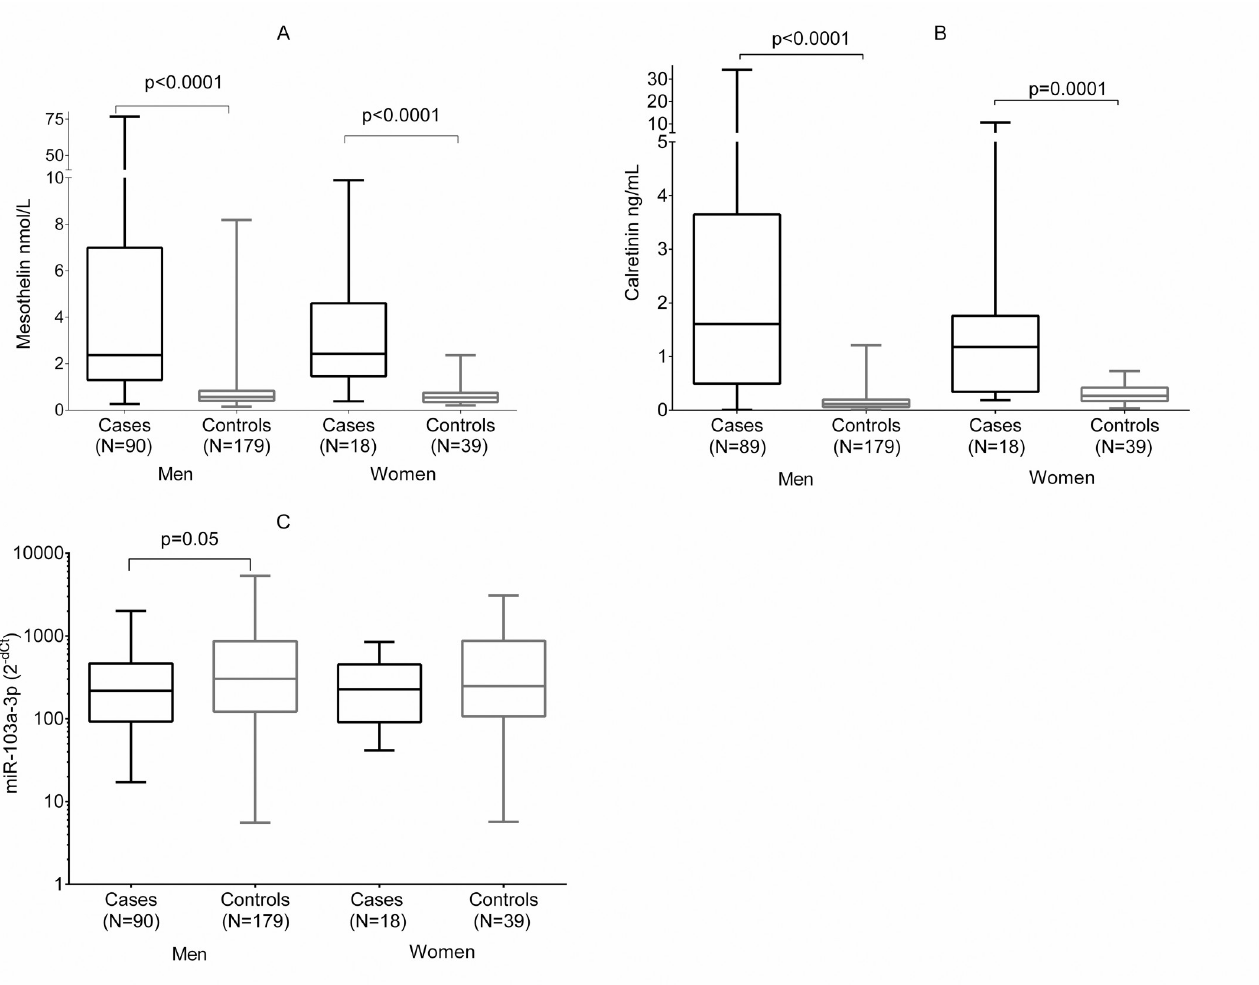
Fig 1. Distribution of medians of mesothelin (A), calretinin (B) and miR-103a-3p (C) in malignant pleural mesothelioma cases and population controls in a Mexican population. Black bars represent cases and gray bars represent